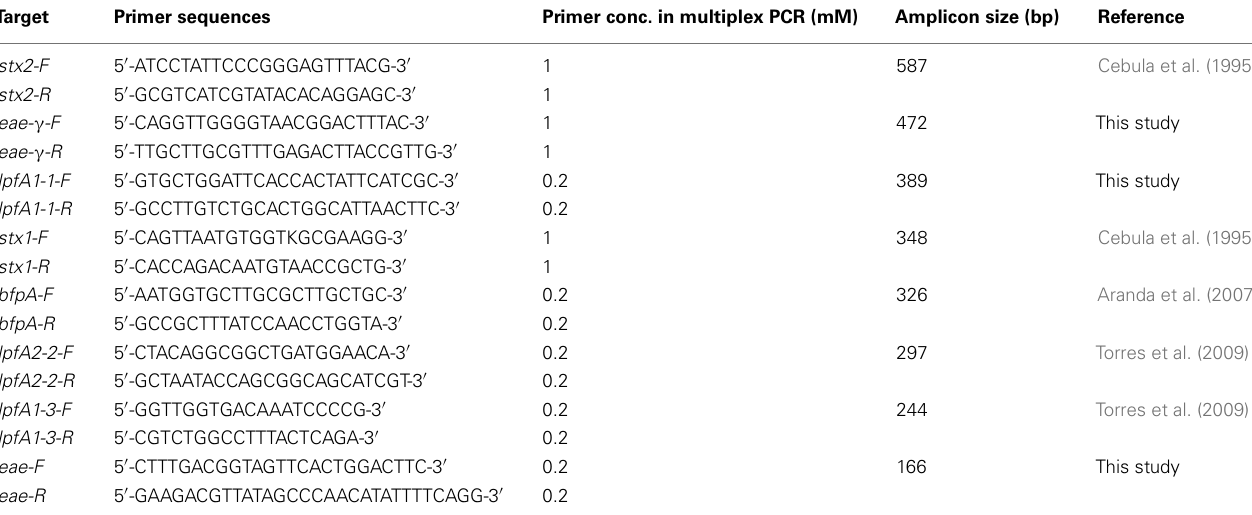
Table 1 |Virulence-associated genes and primers used in this study.